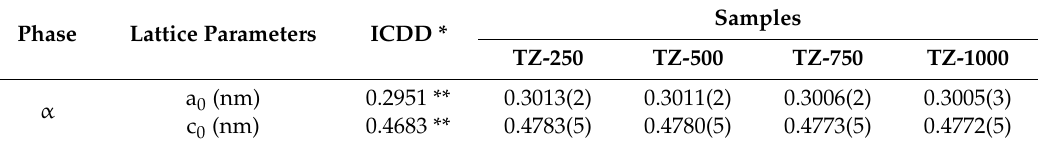
Table 1. Lattice parameters of α phase of samples after di ff erent isostatic pressure and sintering at 1000 ◦ C for 24